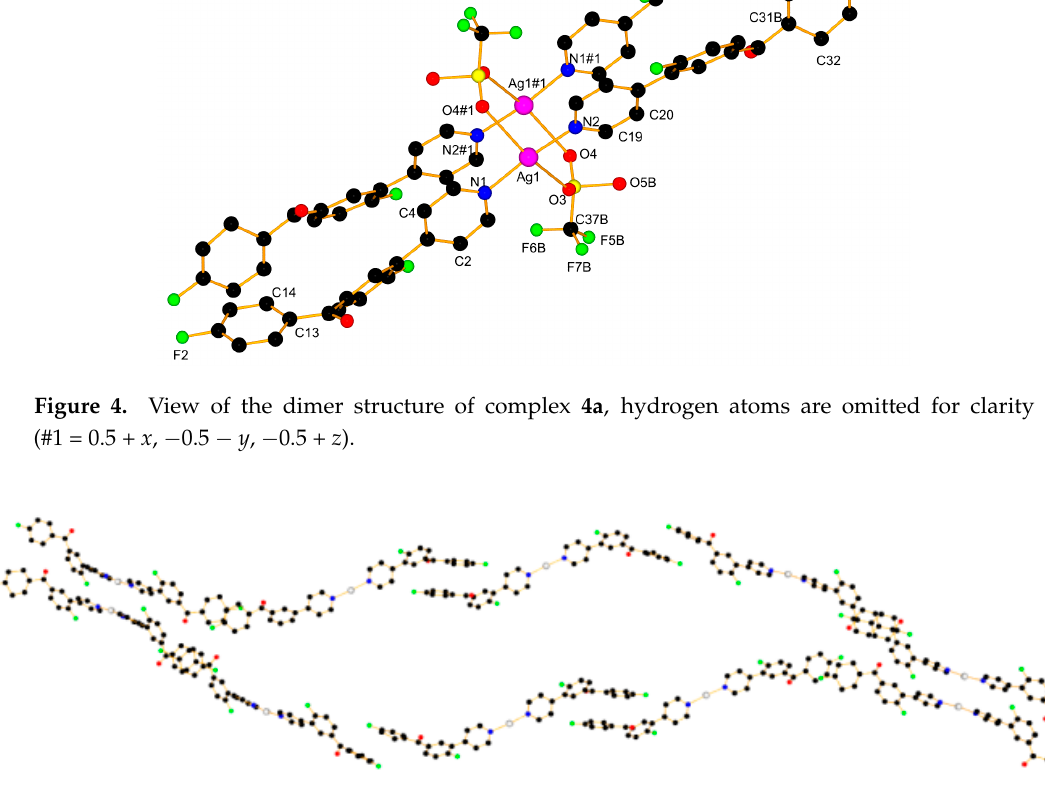
Figure 5. View of the packing of 4a . Hydrogen Atoms and trifluoromethane sulfonate were omitted for clarity. Different colors have been attributed to the different atoms (black: C, blue: N, red: O, yellow: P, green: F, grey: Ag).